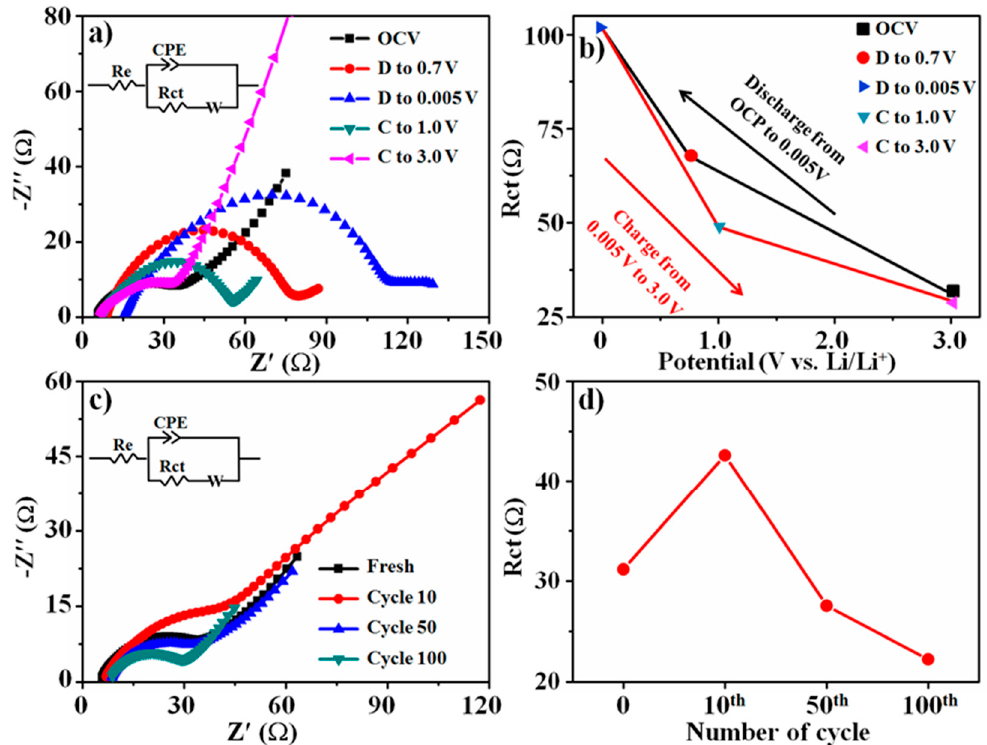
Figure 6. ( a ) The ex situ EIS spectrum evolution of B-SFO@C electrode at the different state of charge and equivalent circuit (inset), ( b ) the corresponding fitted R ct ( c ) EIS spectra of the B-SFO@C electrode at the different cycles and equivalent circuit (inset), ( d ) the corresponding fitted R ct .